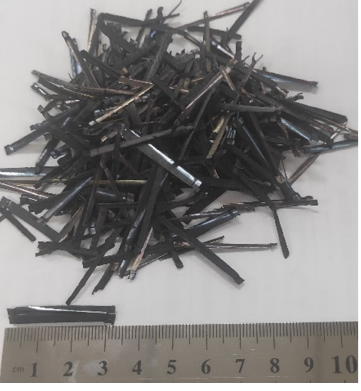
Figure 1. Mill steel fiber.